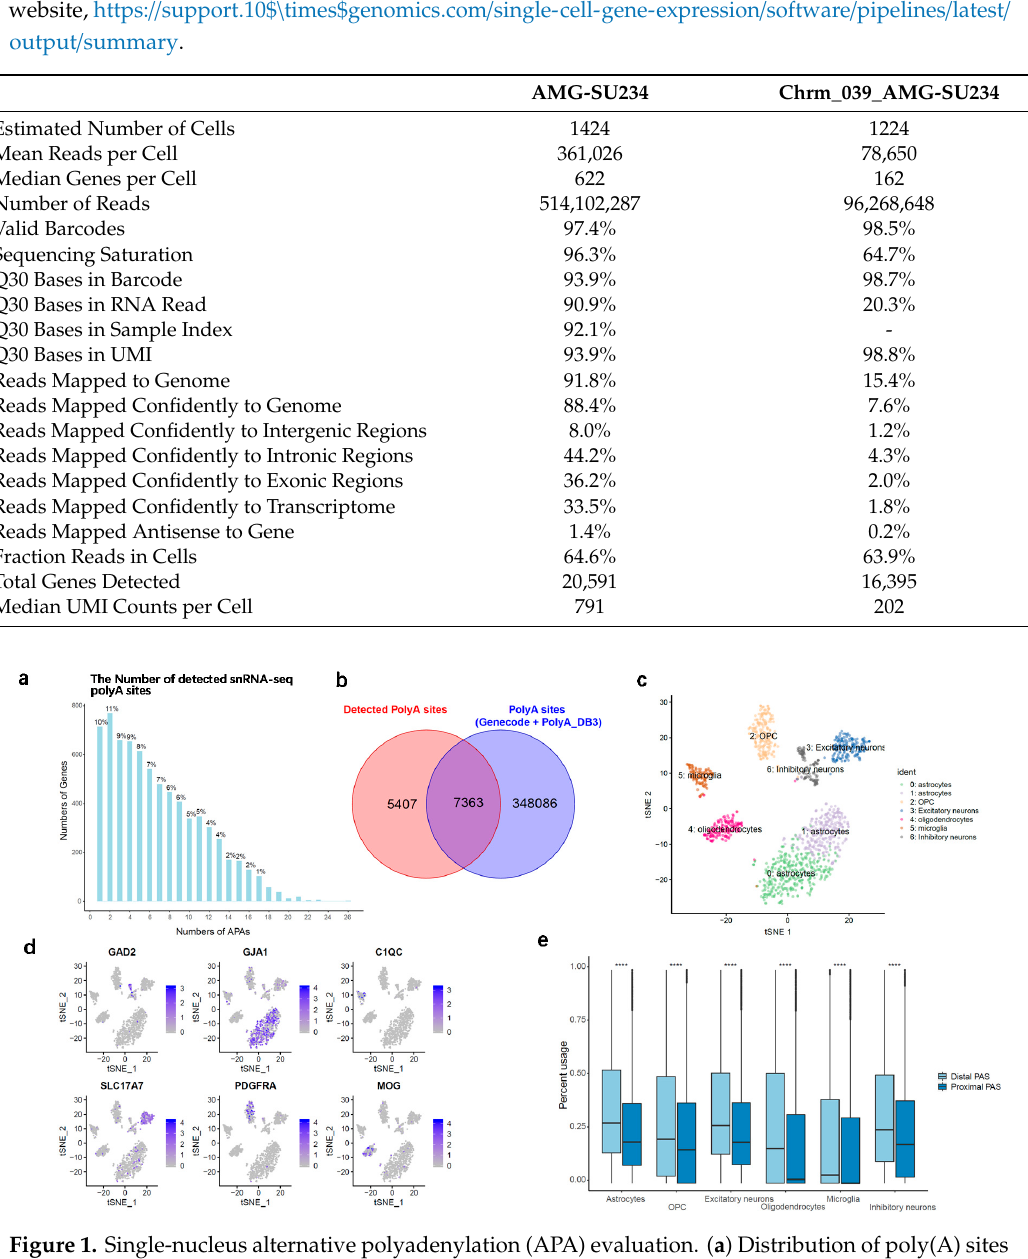
Table 1. Summary metrics for 10 × Genomics snRNA-seq. The estimates were produced by CellRanger on raw data. Sample AMG-SU234 (Read 2) was used for quantification and main poly(A) site